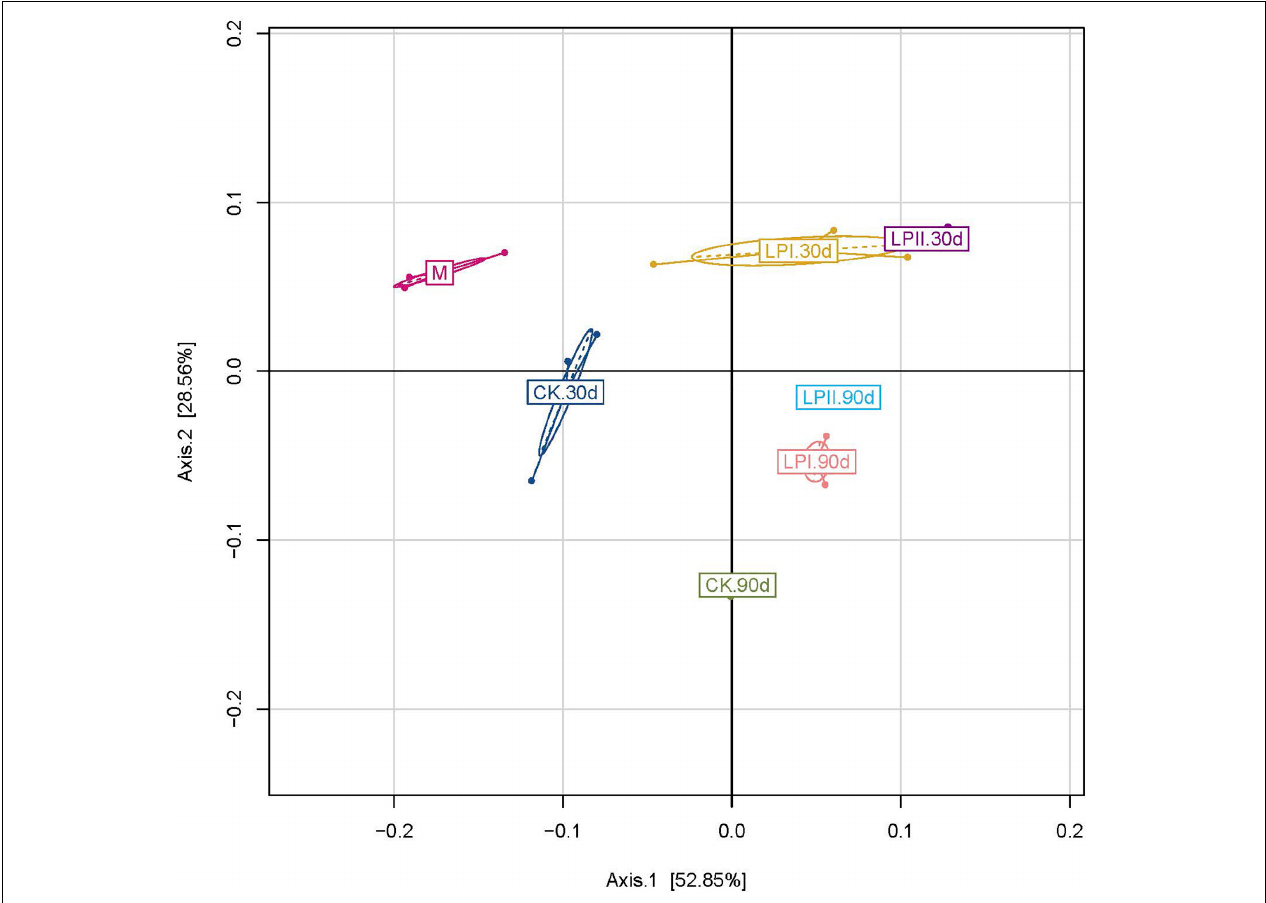
FIGURE 2 | Cluster analysis of bacterial communities in alfalfa silage as assessed by a Principal Coordinate Analysis. M, alfalfa material before ensiling; CK, control; LPI, inoculated with L. plantarum YX; LPII, inoculated with L. plantarum A345. The numbers following CK, LPI, and LPII stand for ensiled days of